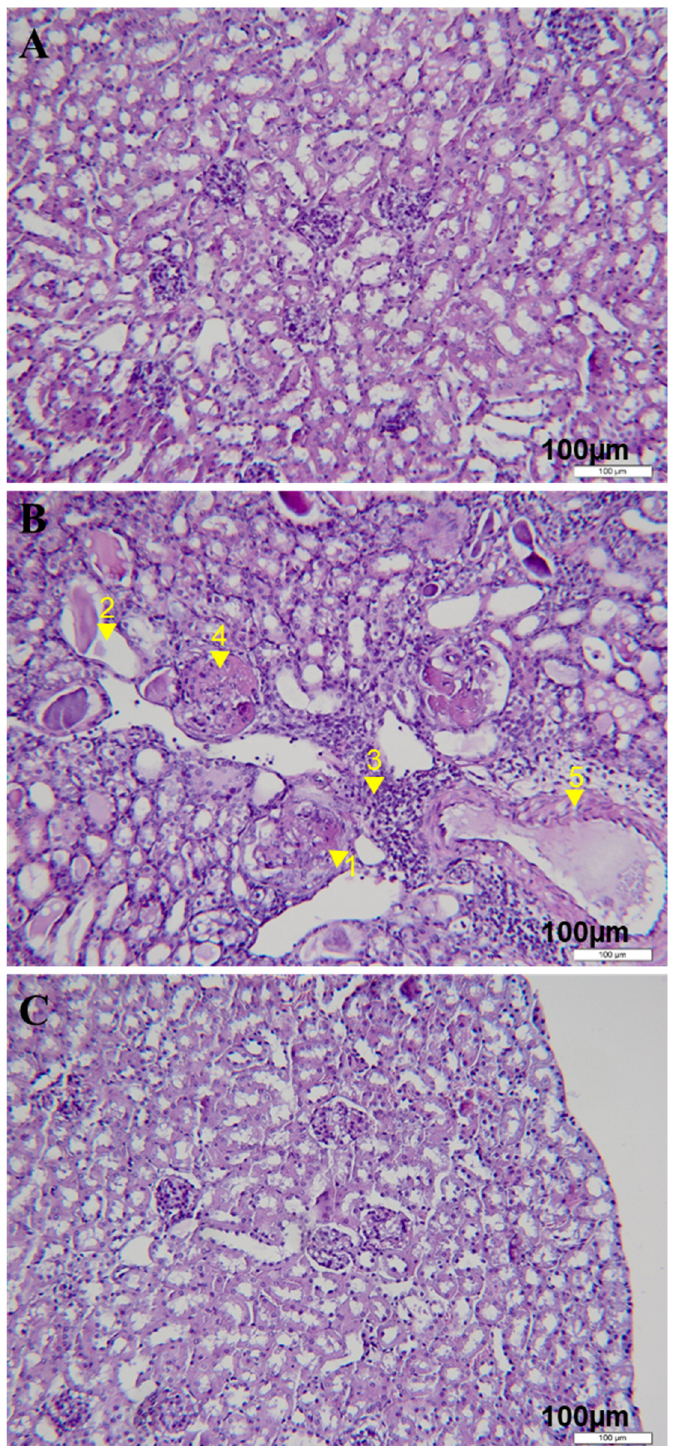
Figure 2. Renal histological analysis of normal mice and experimental mice treated with rapamycin or vehicle control. H&E staining on kidney tissue of normal mice without cell transfer ( A ), vehicle control-treated experimental mice ( B ) and Rapa-treated experimental mice ( C ). The 5 yellow arrows indicate mesangial proliferation (1), tubular dilation (2), leukocytic infiltration (3) and glomerular and vascular sclerosis (4, 5). Kidneys were harvested 12 weeks after transplantation, the representative images are shown.